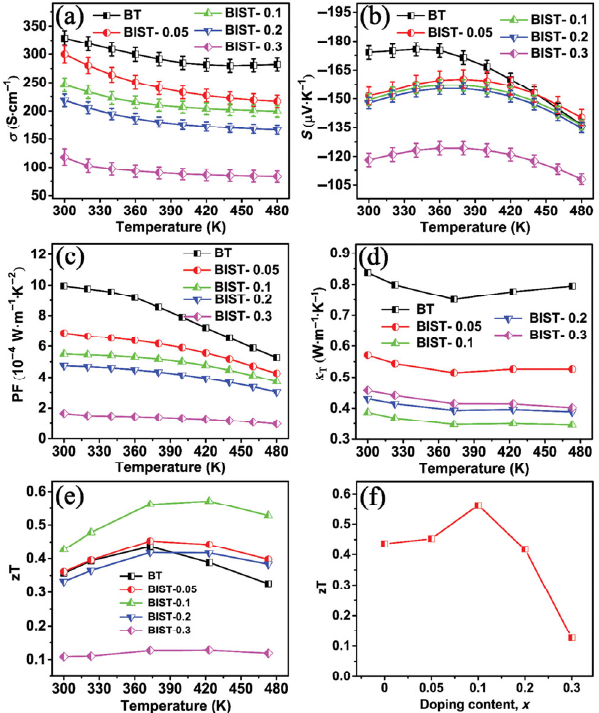
Figure 8 Temperature dependence of the (a) electrical conductivity, (b) Seebeck coefficient, (c) calculated power factor, (d) the total thermal, (e) the TE figure of merit dependence on temperature, (f) the maximum zT dependence on doping content at 423 K for all the BIST samples Bi In Sb Te xx ; x = 0.05, 0.1, 0.2 and 0.3). (where BT = Bi 2 Te 3 , and BIST = 22 33 x - Adapted with permission from Ref. [111], © Wiley-VCH GmbH